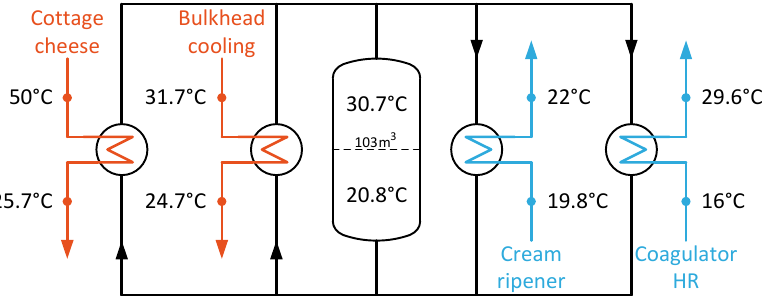
Figure 11. Schematic of solution Variant 1 of Case 2: IHR system with IHR of 1700 kWh. Table 7. Comparison of energy, cost, and economic performance of the different variants in Case 2.